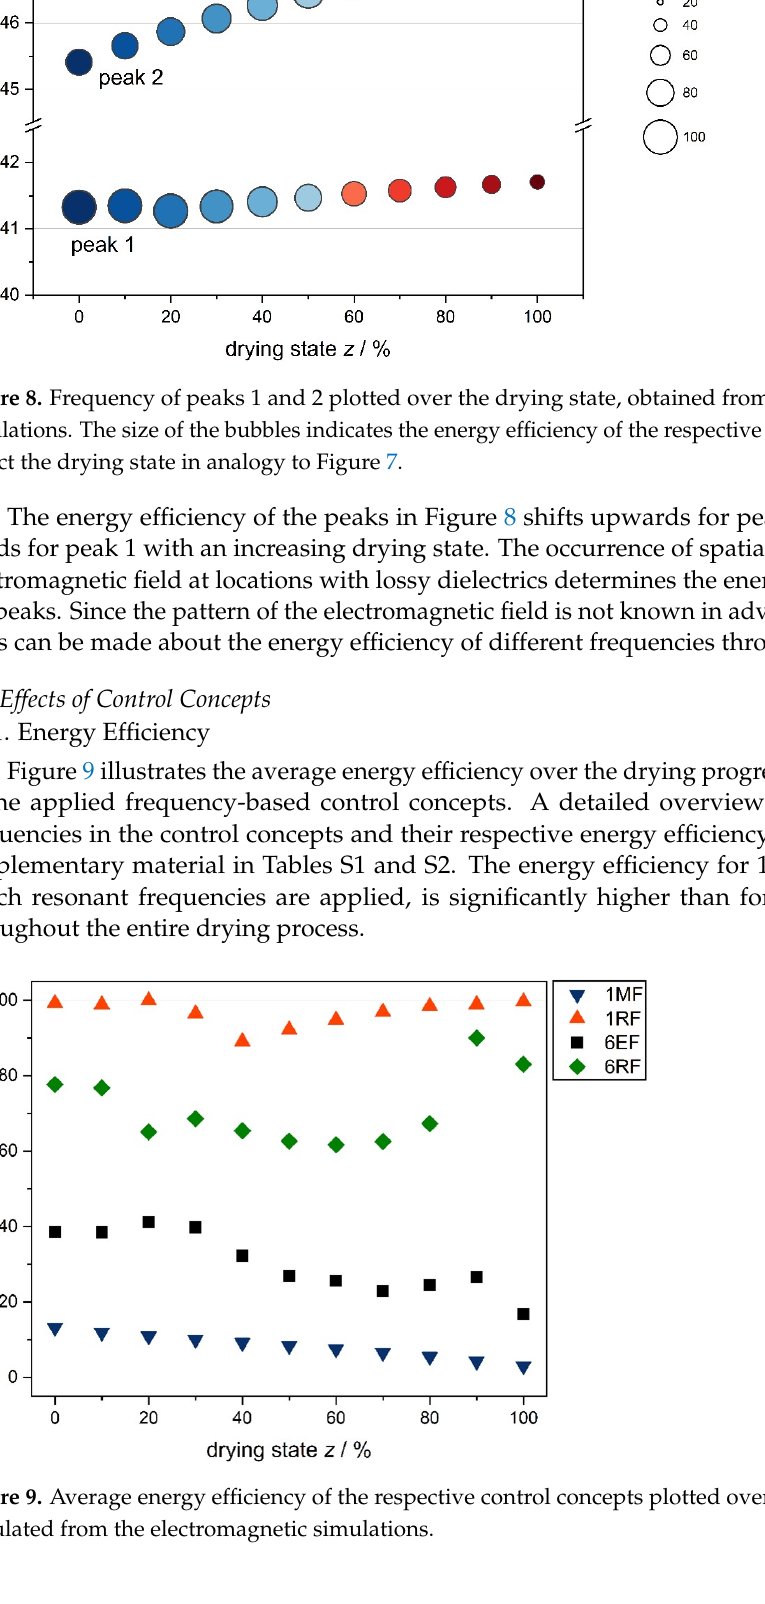
Figure 9. Average energy efficiency of the respective control concepts plotted over the drying state, calculated from the electromagnetic simulations.